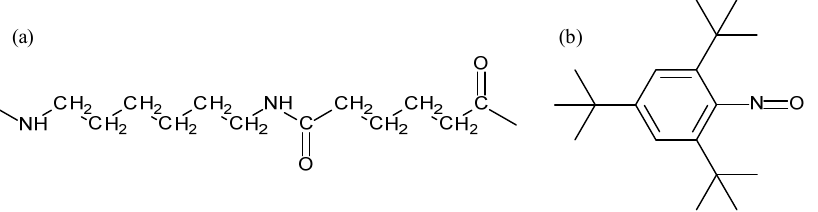
Figure 1. Materials used in this study: ( a ) PA66 and ( b ) spin-trapping reagent 2,4,6-tri- tert -butylnitroso-benzene (TTBNB).